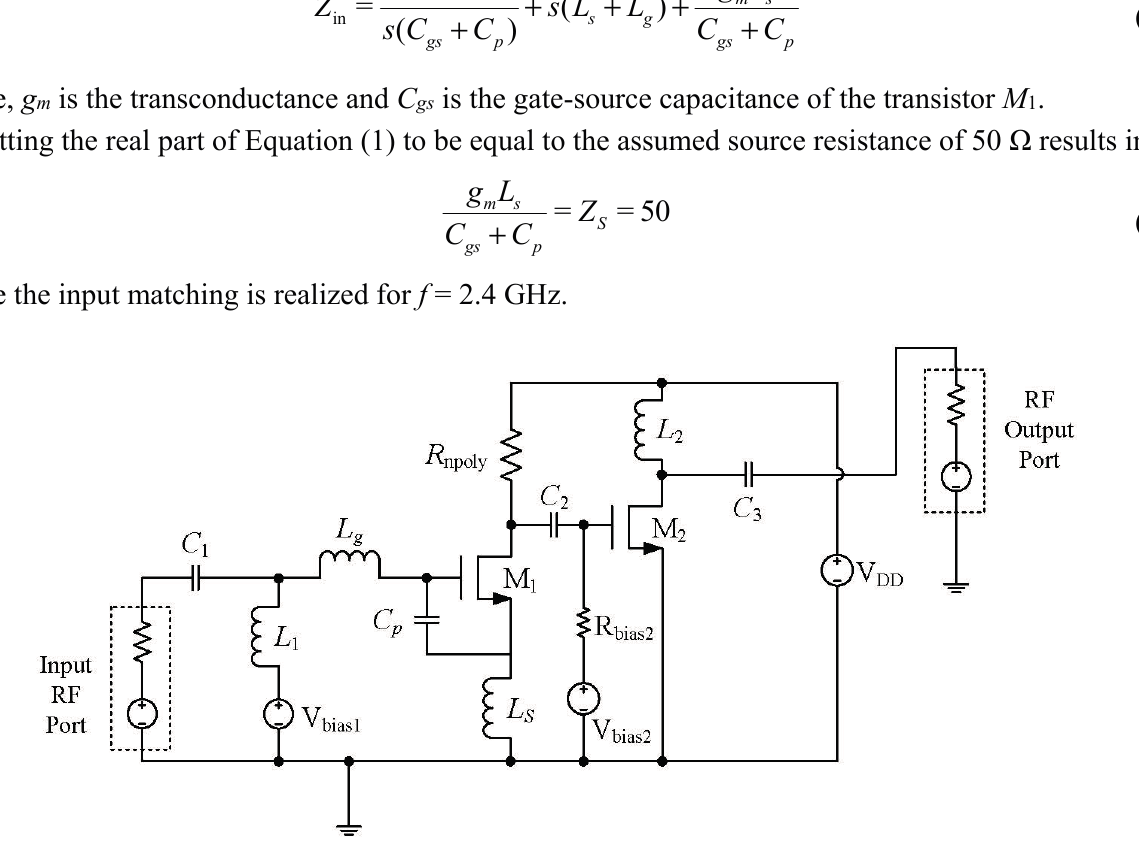
Figure 3. Schematic of the inductively source degenerated narrowband